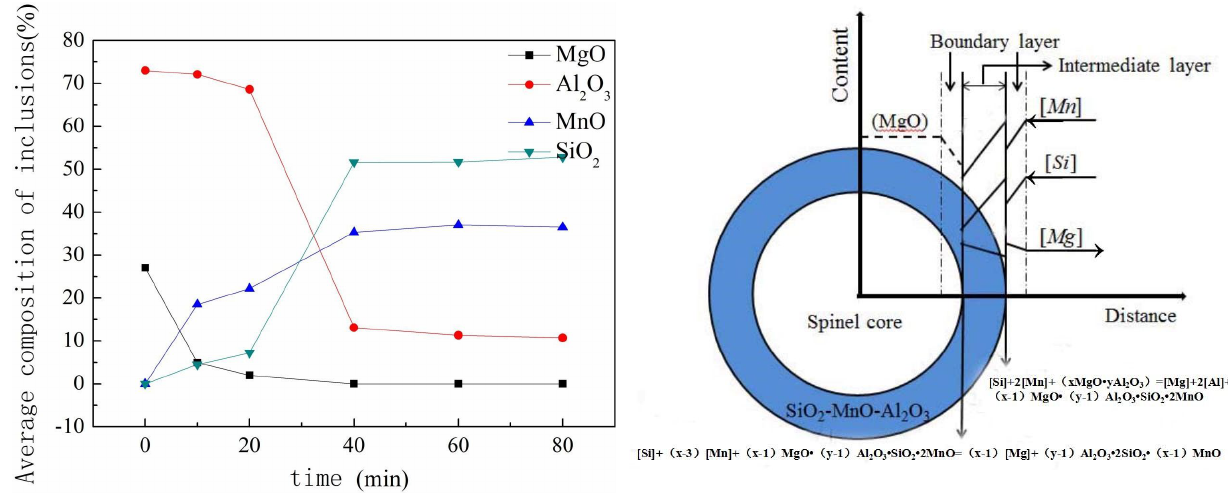
Figure 10: The mechanism of inclusions transformation